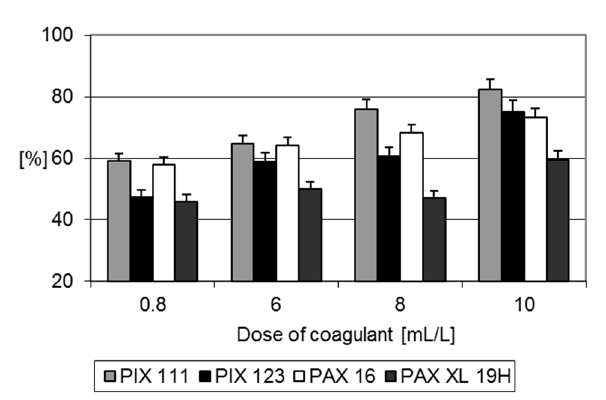
Figure 2. Efficiency of COD removal by coagulation with PIX 111, PIX 123, PAX 16, PAX 19H in the dose ranged from 0.8 to 10 mL/L.